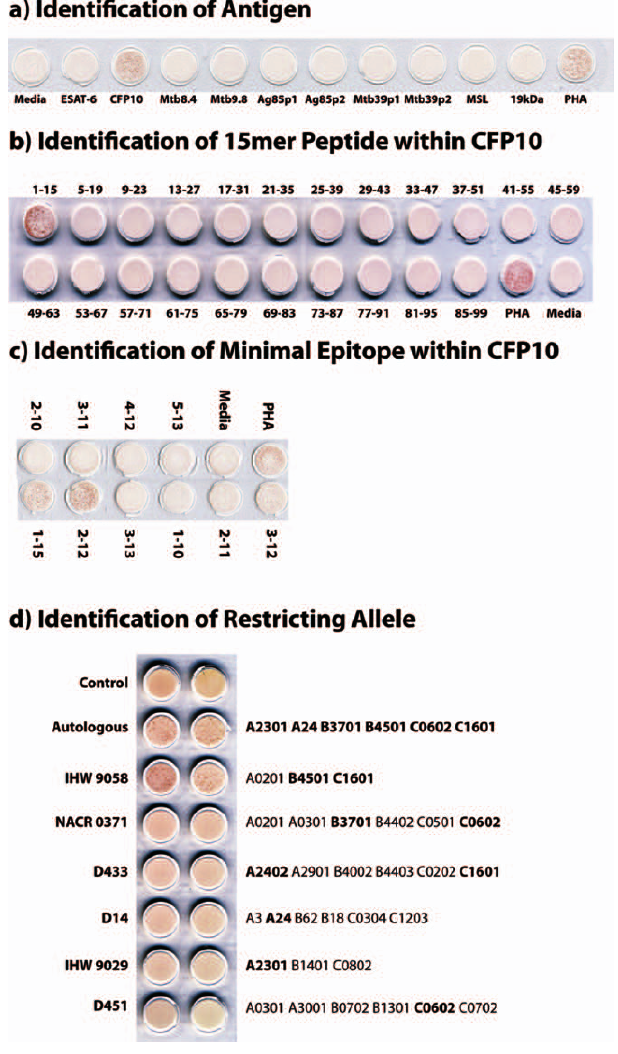
Figure 3. Definition of Antigenic Specificity and HLA Restriction: Characterization of T Cell Clone D466 D6 (A–C) To identify the antigen and minimal epitope recognized by T cell clone D466 D6, T cells (5,000 cells/well) were incubated with autologous LCL (20,000/well) and antigen (5 l g/ml). Negative controls (media, no antigen) and positive controls (phytohemagglutanin [PHA], final, 10 l g/ ml) are shown for each assay. IFN- c was assessed by ELISPOT after 18 h of co-culture. Pictures of ELISPOT wells are shown.